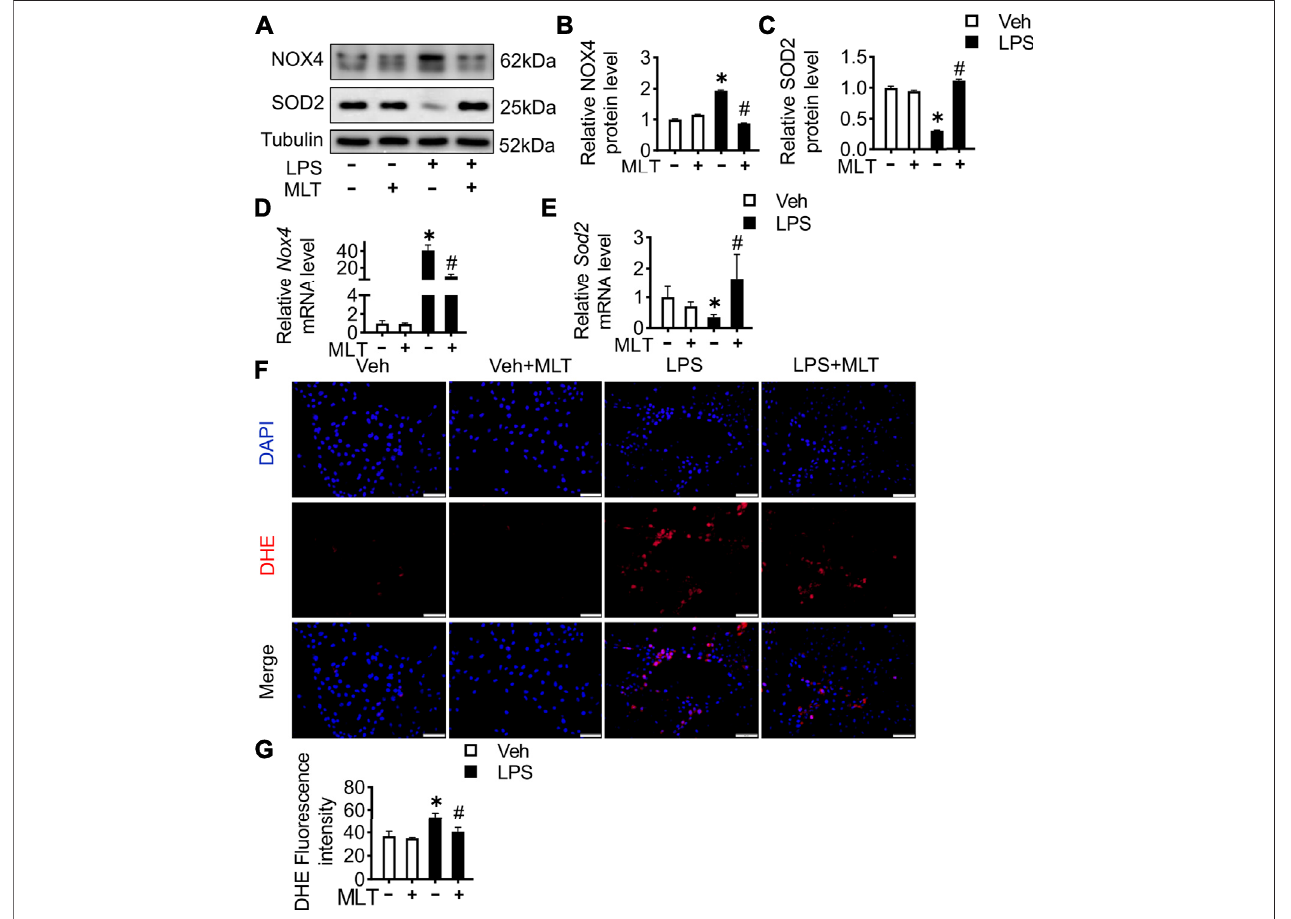
FIGURE 5 | Melatonin reduces ROS production in LPS-treated HK-2 cells. The HK-2 cells were cultured with MLT (5 μ M), and 48 h later, cells was incubated with lipopolysaccharide (LPS, L4391, Sigma) at a concentration of 1 μ g/ml for 24 h. (A) Protein expression levels of NOX4 and SOD2 in the HK-2 cells were measured by Westernblotting.Theexpression levelsofNOX4 (B) and SOD2 (C) werequanti fi ed(*vs. Veh, p < 0.05;#vs.LPS, p < 0.05). Nox4 (D) and Sod2 (E) mRNAlevelsofcells are measured using RT-PCR (* vs. Veh, p < 0.05; # vs. LPS, p < 0.05). (F) Representative images of DHE staining of HK-2 cells (scale bar (cid:1) 50 µm). (G) ROS production was quanti fi ed and presented as the mean fl uorescence intensity (* vs. Veh, p < 0.05; # vs. LPS, p < 0.05).